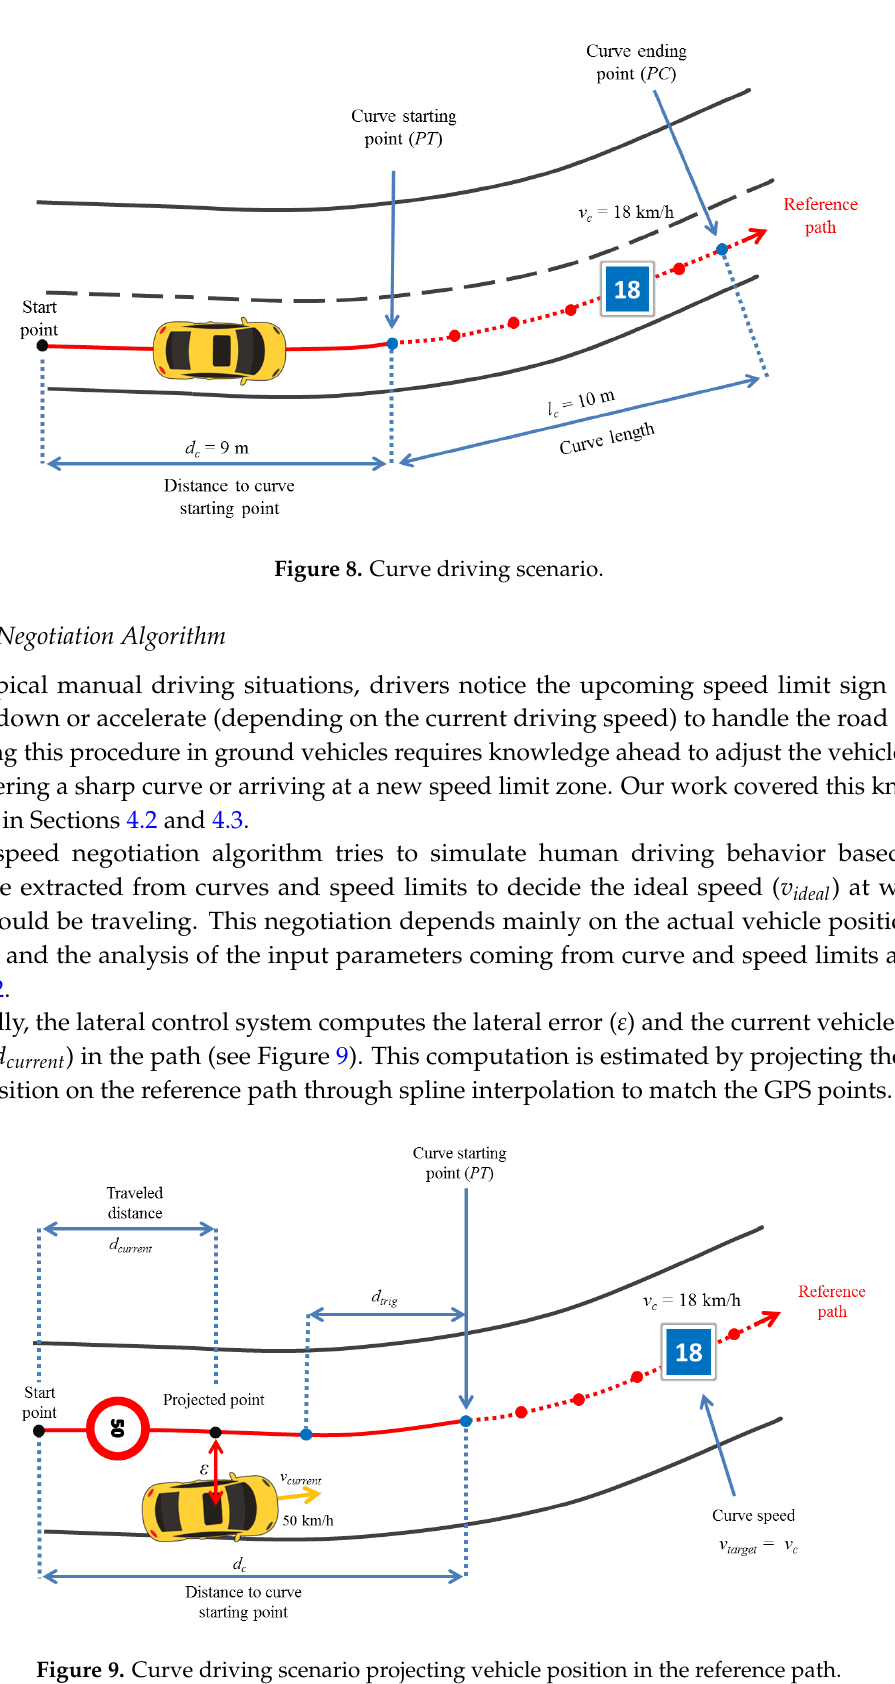
Figure 9. Curve driving scenario projecting vehicle position in the reference